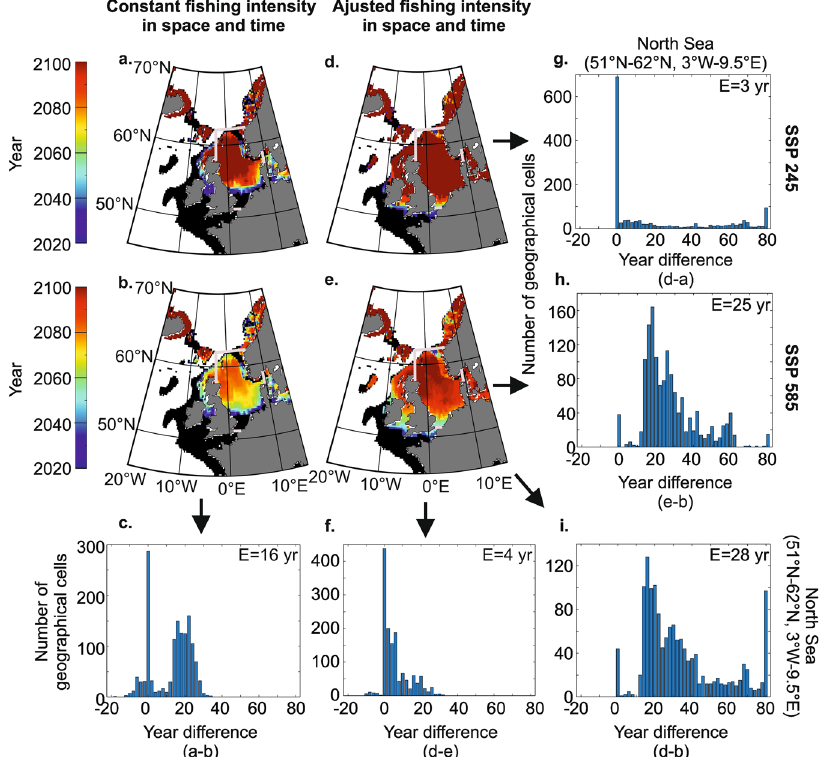
Fig. 4 Effect of cod management and anthropogenic climate change on year of cod extirpation in 2020 – 2100 with a focus in the North Sea. a – d Maps of year of cod extirpation based on a constant ( a , b ) and an adjusted (MSY) ( d , e ) fi shing intensity in space and time and scenario SSP245 ( a , d ) and 585 ( b , e ). Thick magenta lines display the North Sea boundaries used to calculate histograms. c , f – i Frequency histograms of difference between maps of time to extirpation for the North Sea (51°N-62°N and 3°W-9.5°E). c Year difference between the maps of ( a , b ). f Year difference between the maps of ( d , e ). g Year difference between the maps of ( d , a ). h Year difference between the maps of ( e , b ). i Year difference between the maps of ( d , b ). The value of median E (expressed in year, yr) is indicated on all